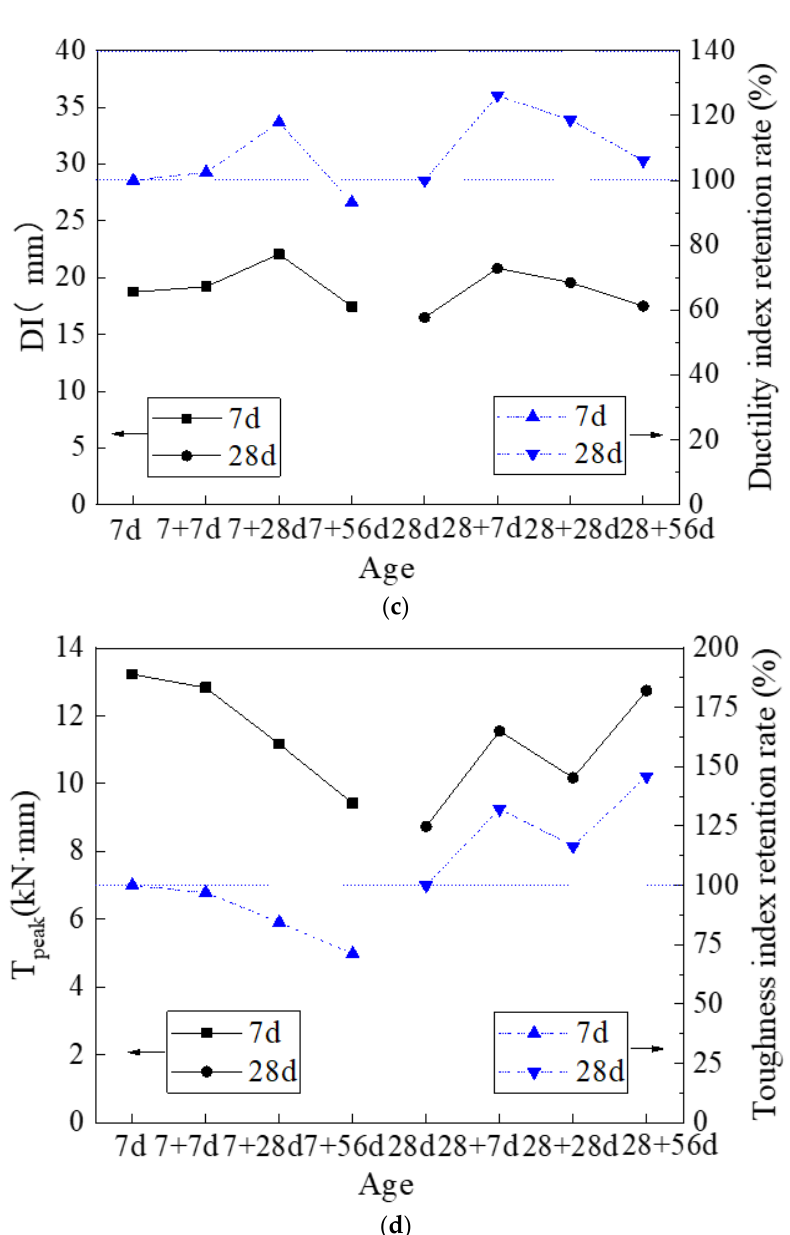
Figure 7. ( a ) First-crack strength, ( b ) ultimate flexural strength, ( c ) ductility index, and ( d ) toughness index, together with their retention rates, of HDMC with different ambient curing ages and water immersion ages.